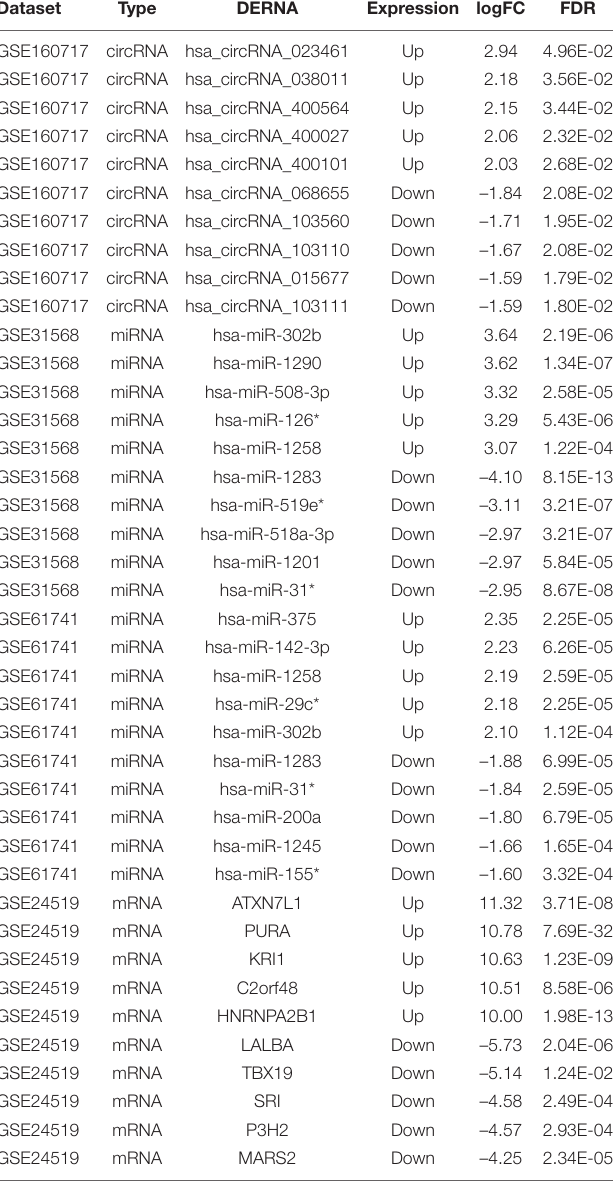
TABLE 2 | The top 5 high-expressed DERNAs and the top 5 low-expressed DERNAs in each dataset.